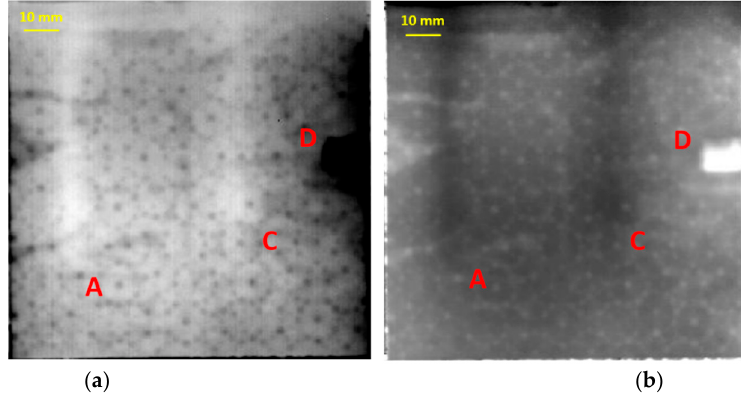
Figure 4. Result images after data processing: ( a ) Third empirical orthogonal function by principal component thermography (PCT) in transmission mode; and, ( b ) Phasegram by pulsed phase thermography (PPT) at f = 0.014 Hz in transmission mode.